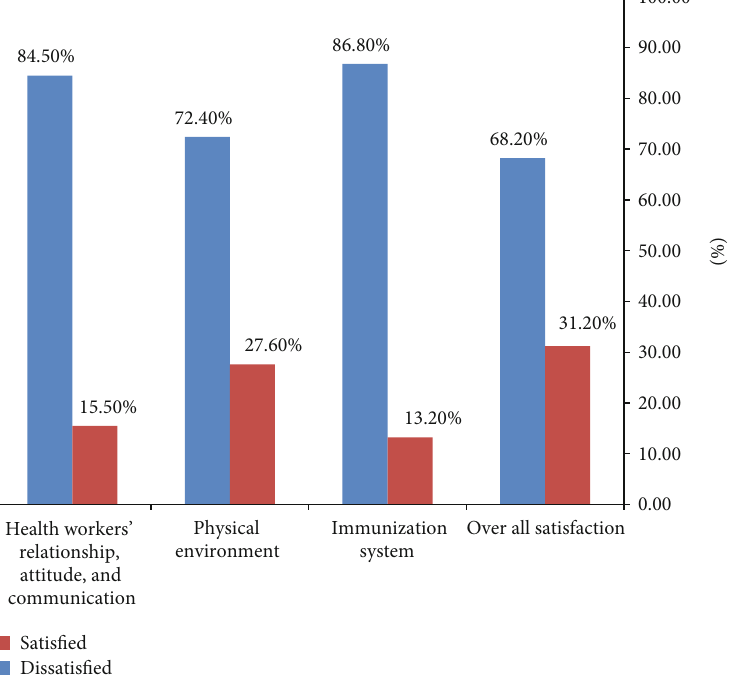
Figure 3: Maternal satisfaction for respondents whose children are receiving immunization service in Wadla district, North Wollo, Amhara regional state, northeast Ethiopia,